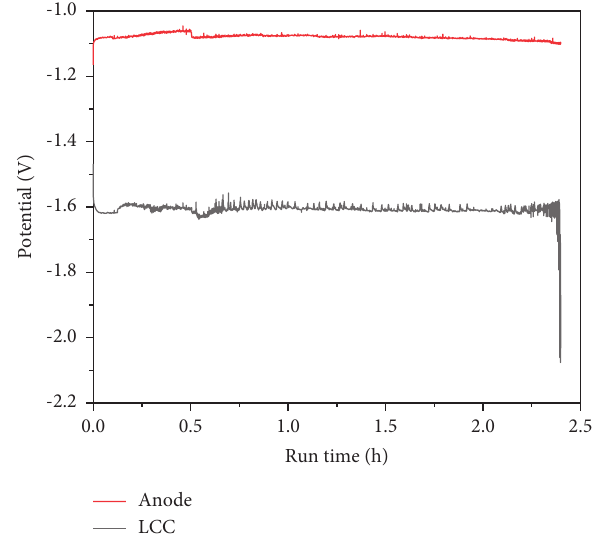
Figure 3: Potential profiles of run 1 using the stirred LCC im- mersed in LiCl-KCl-UCl 3 at 500 °